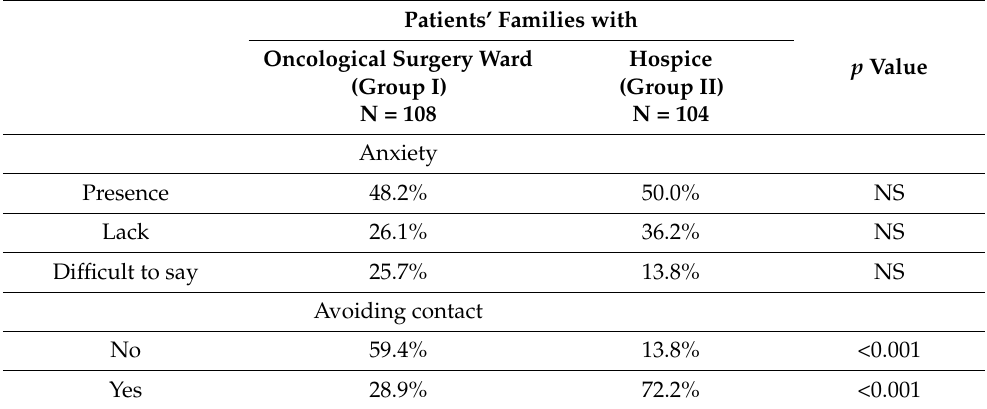
Table 2. The respondents’ opinions about their feelings during contact with the dying. Patients’ Families